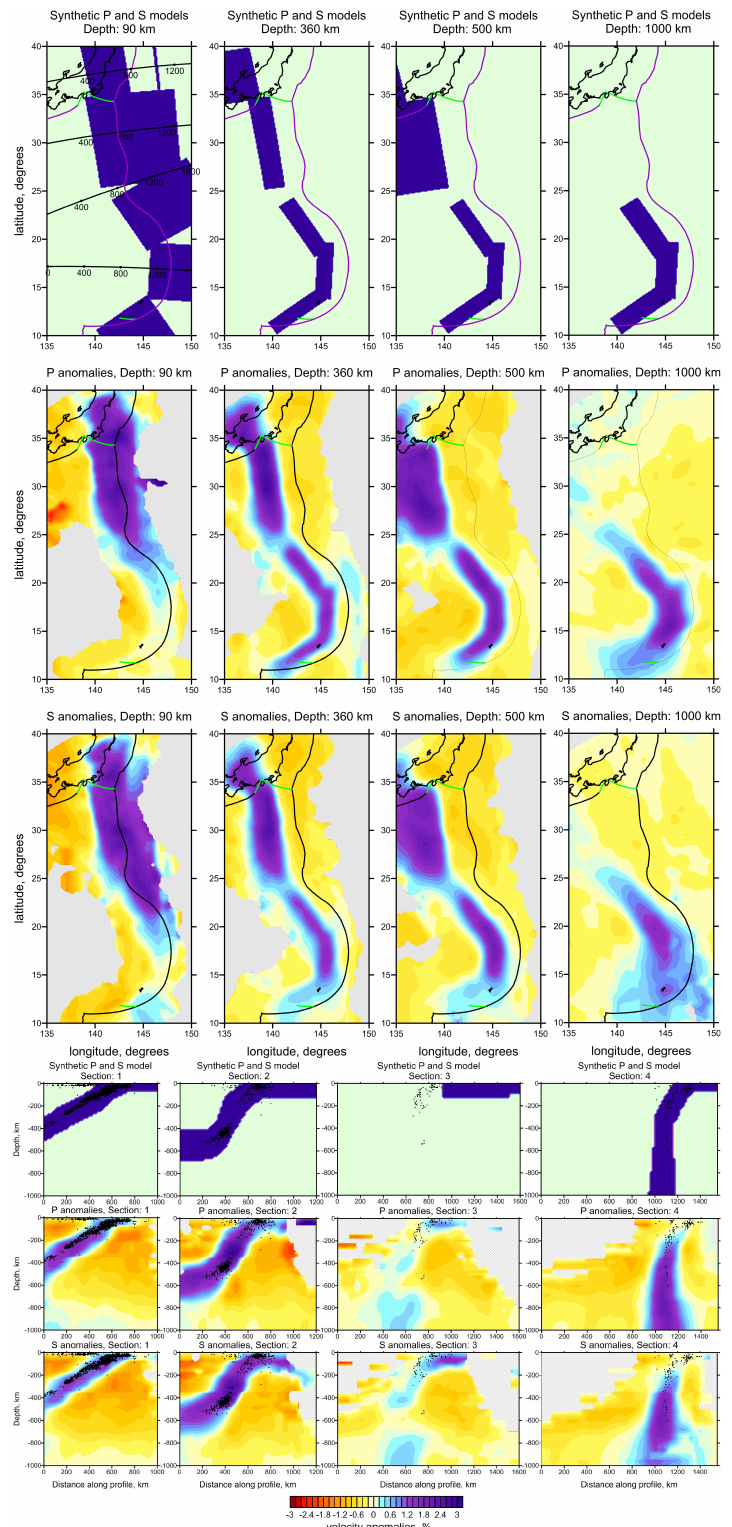
Fig. 8. Synthetic tests with slab-shaped anomalies. The results of inversion are shown in horizontal and vertical sections. Locations of the profiles are shown in map corresponding to the model definition at 90km